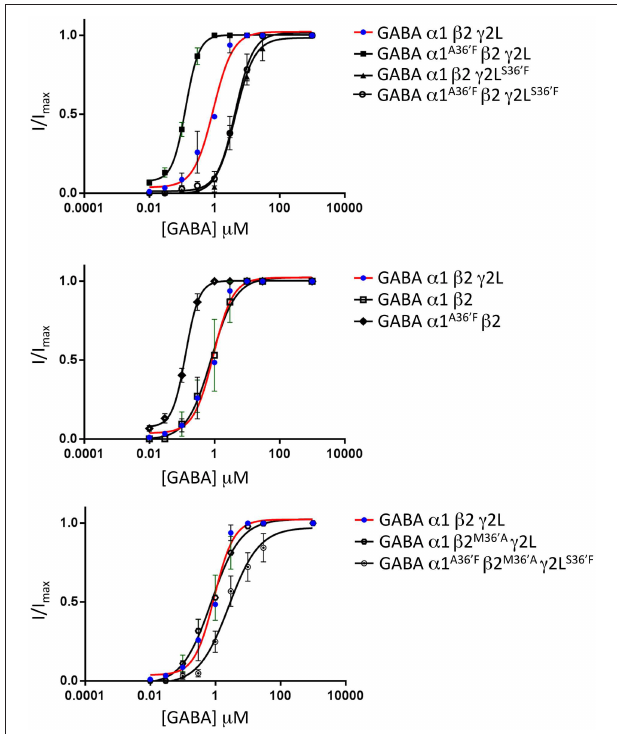
FIGURE 4 | Mean agonist concentration-response relationships of all GABA A R subunit combinations investigated in this study. The wild type α 1 β 2 γ 2L data, shown as blue points and red curve fits, are reproduced in all panels to facilitate comparison between panels. All data points were averaged from 4 to 6 cells and individual concentration-response curves were fitted by the Hill equation. The mean Hill equation parameters of best fit are summarized in Table 1 .